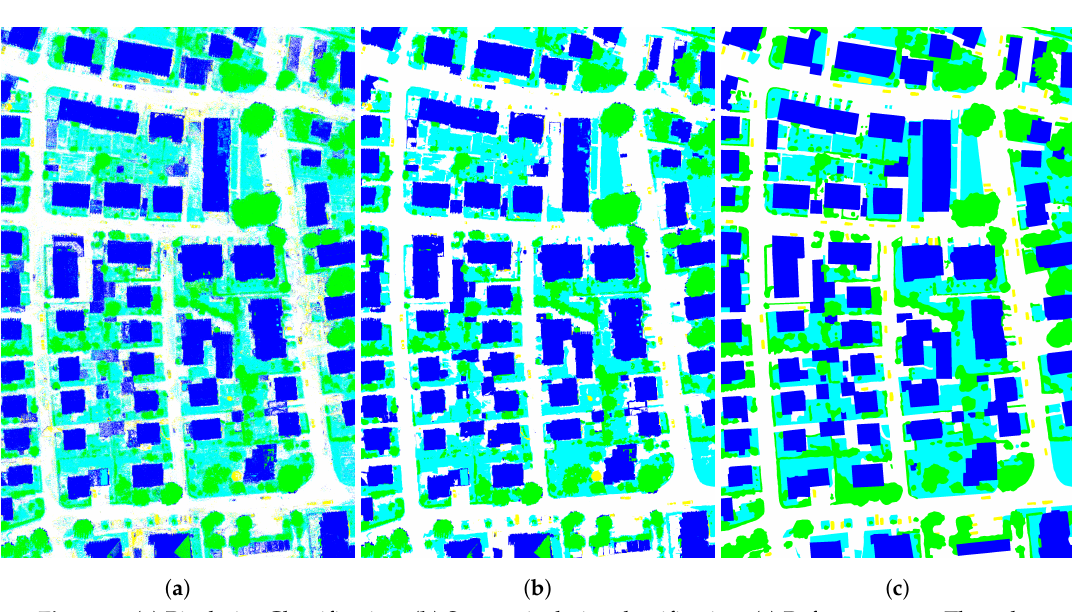
Figure 8. ( a ) Pixelwise Classification, ( b ) Super-pixelwise classification, ( c ) Reference map. The color legend for the classes is as follows: building (blue), low vegetation (cyan), tree (green), impervious surface (white), car